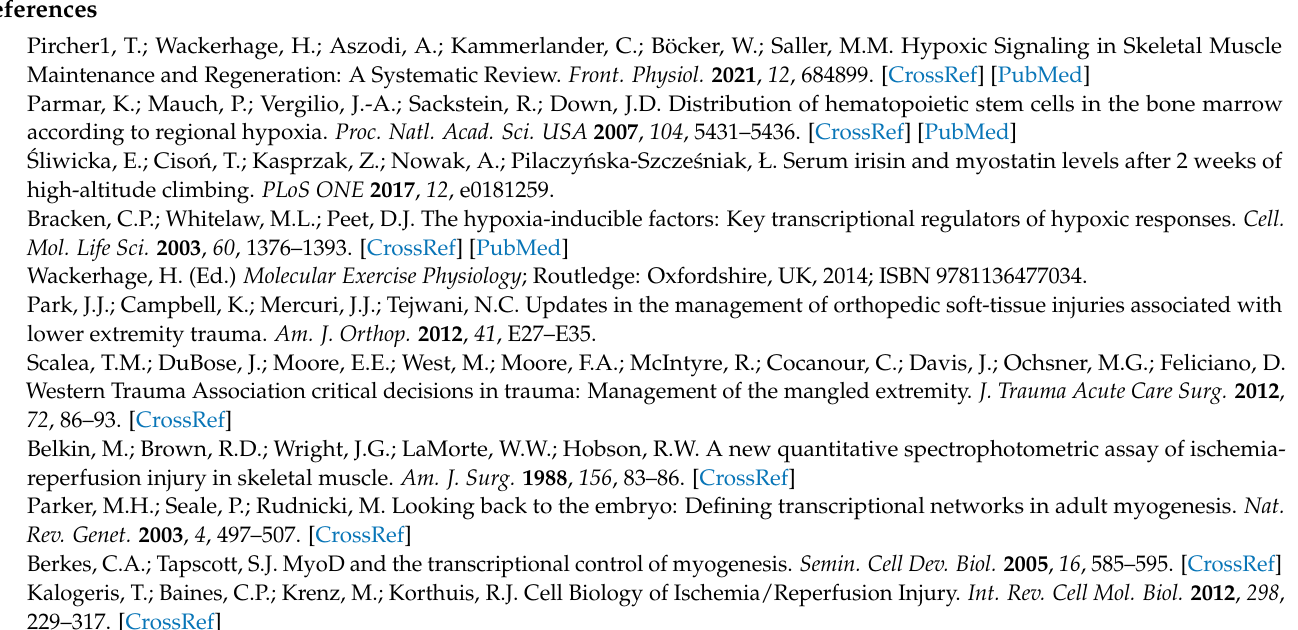
Figure S2: Hallmark gene sets over time. Table S1: Differentially expressed